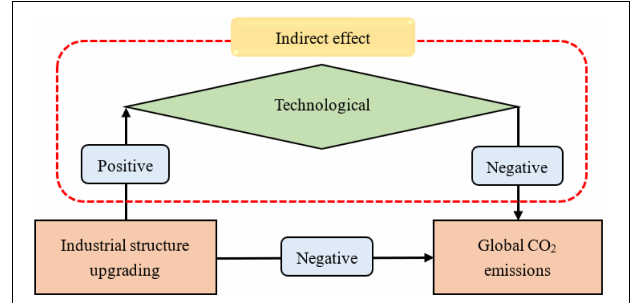
FIGURE 2 | The specific impact mechanism between industrial structure upgrading and CO 2